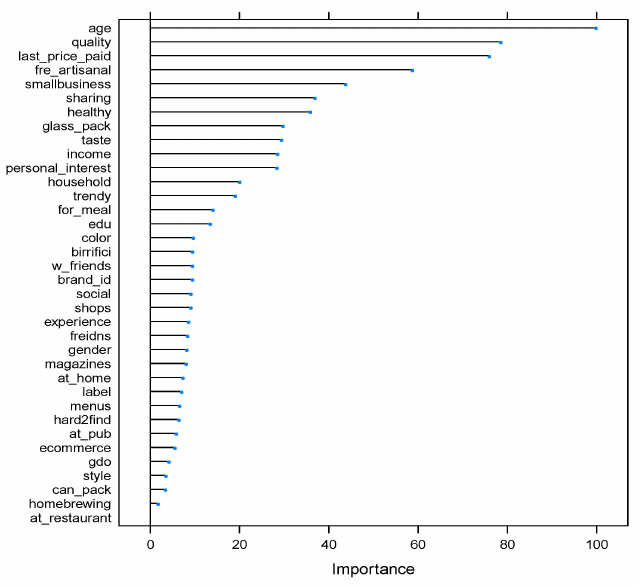
Figure 1. Random forest estimation of attribute importance. Representation of the results.